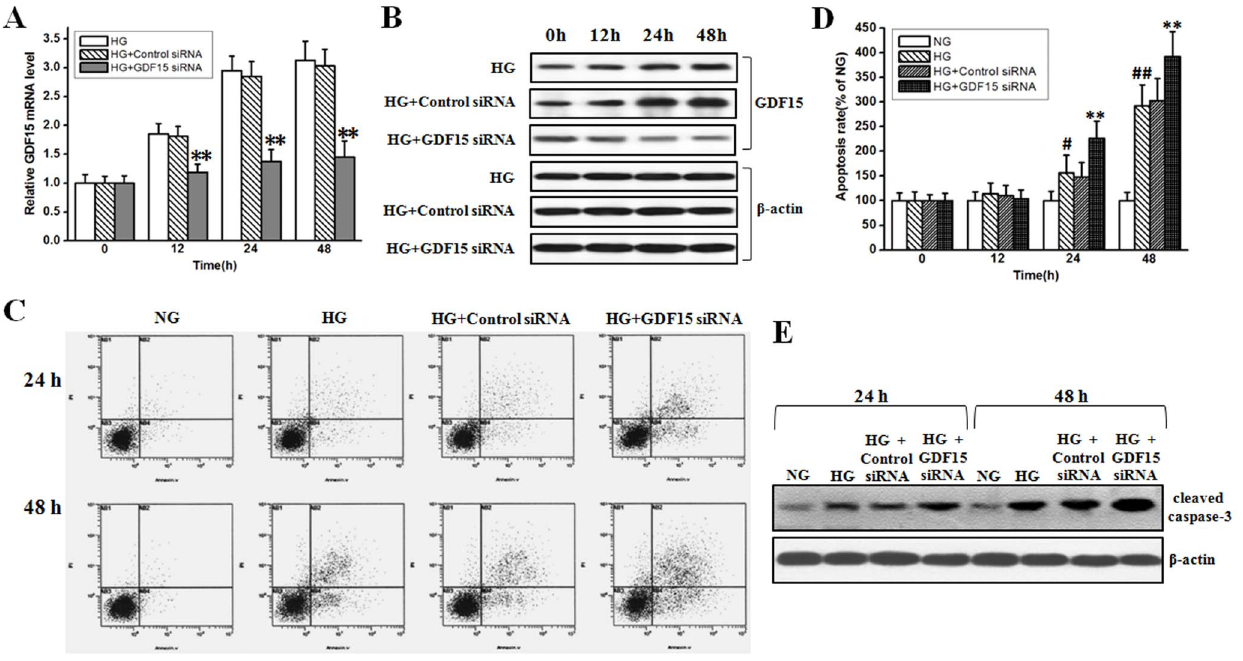
Figure 4. Inhibition of adaptively induced GDF15 expression enhanced high glucose-induced HUVEC cell apoptosis. GDF15 siRNA or negative control siRNA were transfected into HUVEC cells. 12 h after transfection, HUVEC cells were treated with normal (5.5 mmol/l) or high (33.3 mmol/l) glucose. A, B, mRNA and protein levels of GDF15 was detected to test the efficiency of GDF15 siRNA. C, D, FCM results and statistical analysis of high glucose-induced HUVEC cell apoptosis with or without GDF15 siRNA transfection. E, high glucose-induced caspase-3 cleavage with or without GDF15 siRNA transfection. NG, normal glucose. HG, high glucose. *, P , 0.05, **, P , 0.01 versus HG. # , P , 0.05, ## , P , 0.01 versus NG.